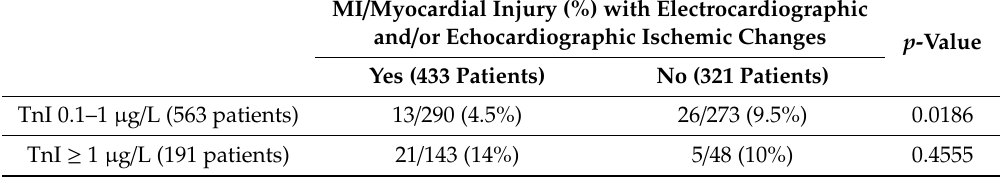
Table 3. In-hospital mortality (%) per MI / myocardial injury (%) with electrocardiographic and / or echocardiographic ischemic changes and troponin level.